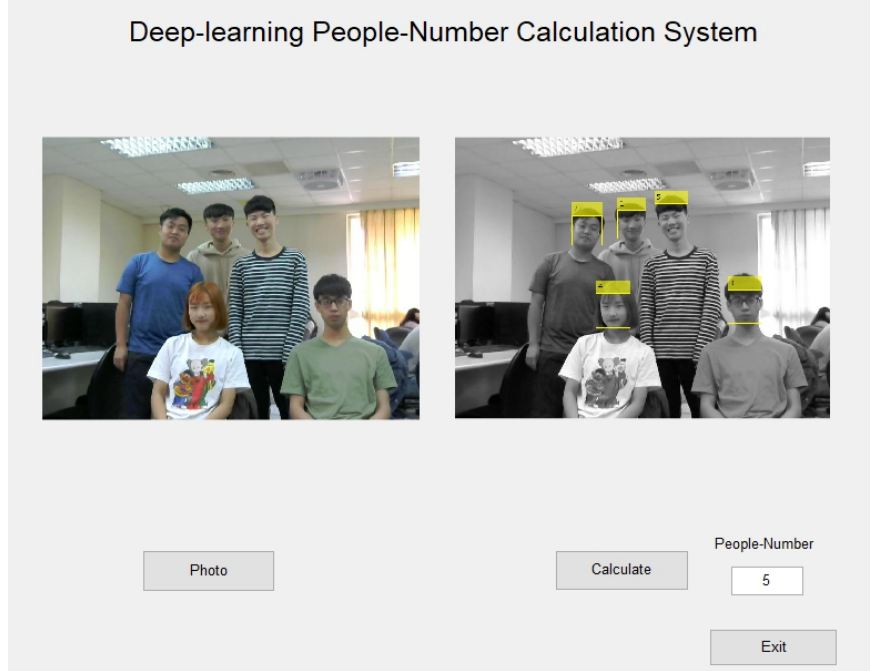
Figure 1. The GUI of the proposed calculator for calculating the number of people in a photo.